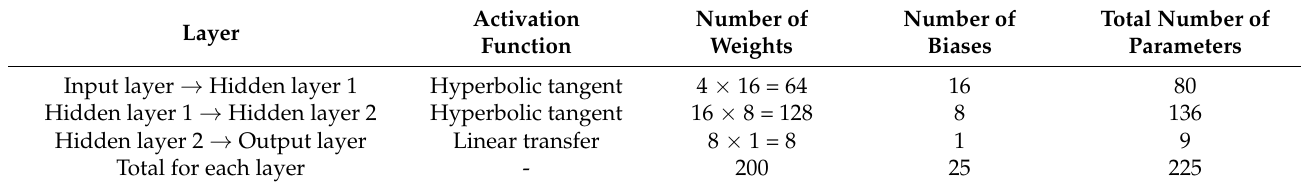
Figure 3. Schematic diagram of the artificial neural network. Figure 3. Structure of the artificial neural network. Table 1. Hyperparameters of the artificial neural network. Table 1. Hyperparameters of the artificial neural network.